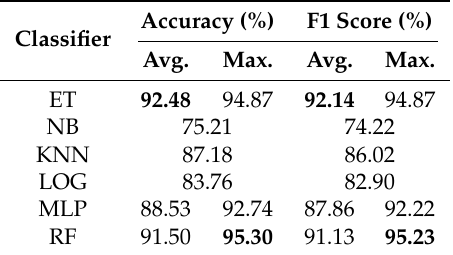
Table 5. Classifiers’ accuracy and F1 (wrist + pocket). Boldface indicates the best